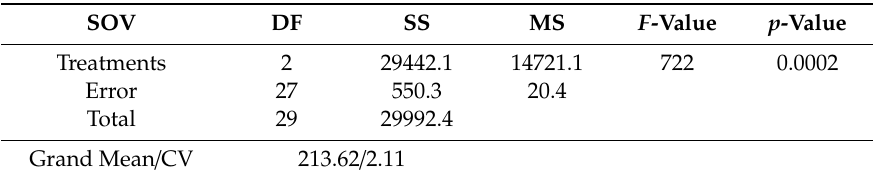
Table A4. Di ff erences of M. persicae number after 15 days in PeBL1-treated, bu ff er, and control cucumber seedlings.